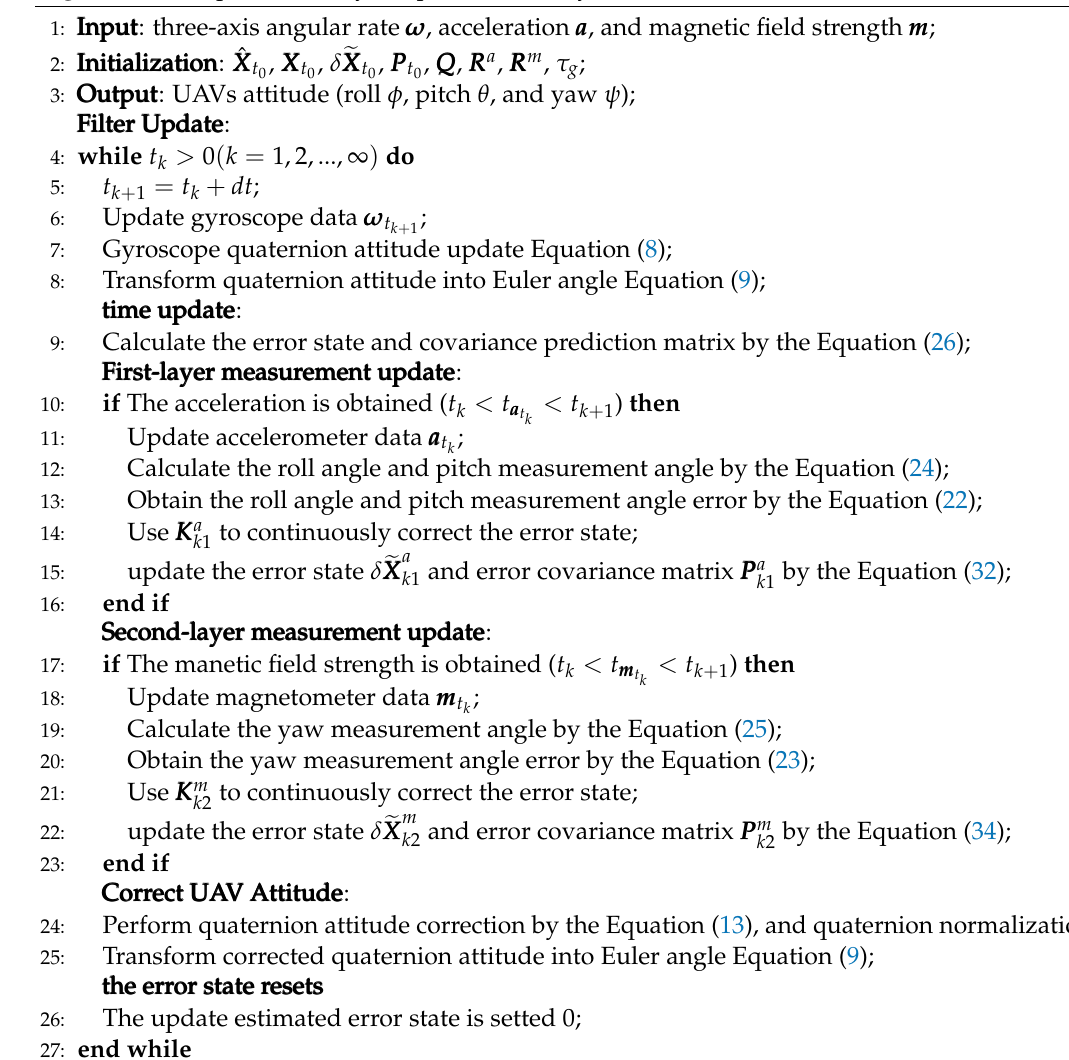
Algorithm 1 Proposed weakly-coupled double-layer